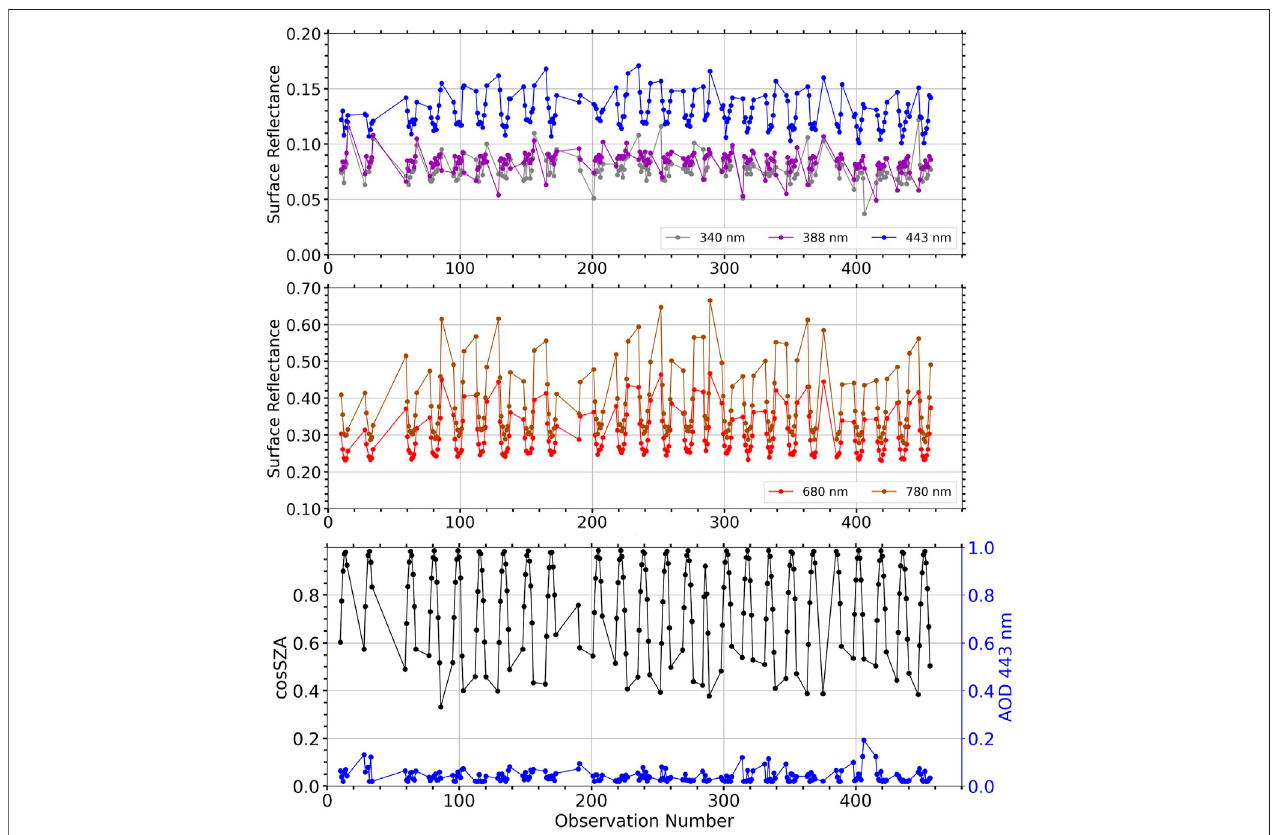
FIGURE5| Thetimeseriesofsurfacere fl ectanceinEPIC ’ sUV-vis-NIRbandsoverthebrightpixelinArizona,UnitedStates,inJune – earlyJulyof2020.Thebottom plot shows cosine of solar zenith angle and retrieved AOD at 443 nm. The x -axis counts consecutive EPIC observations from June 2 through July 2 of 2020.